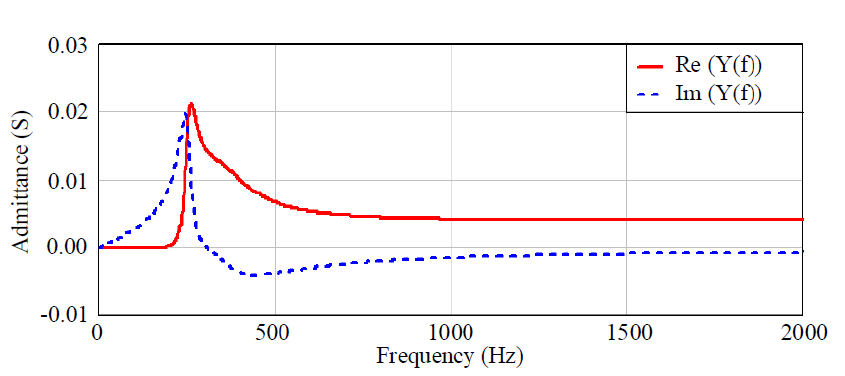
Figure 11. Frequency characteristics of passive filter